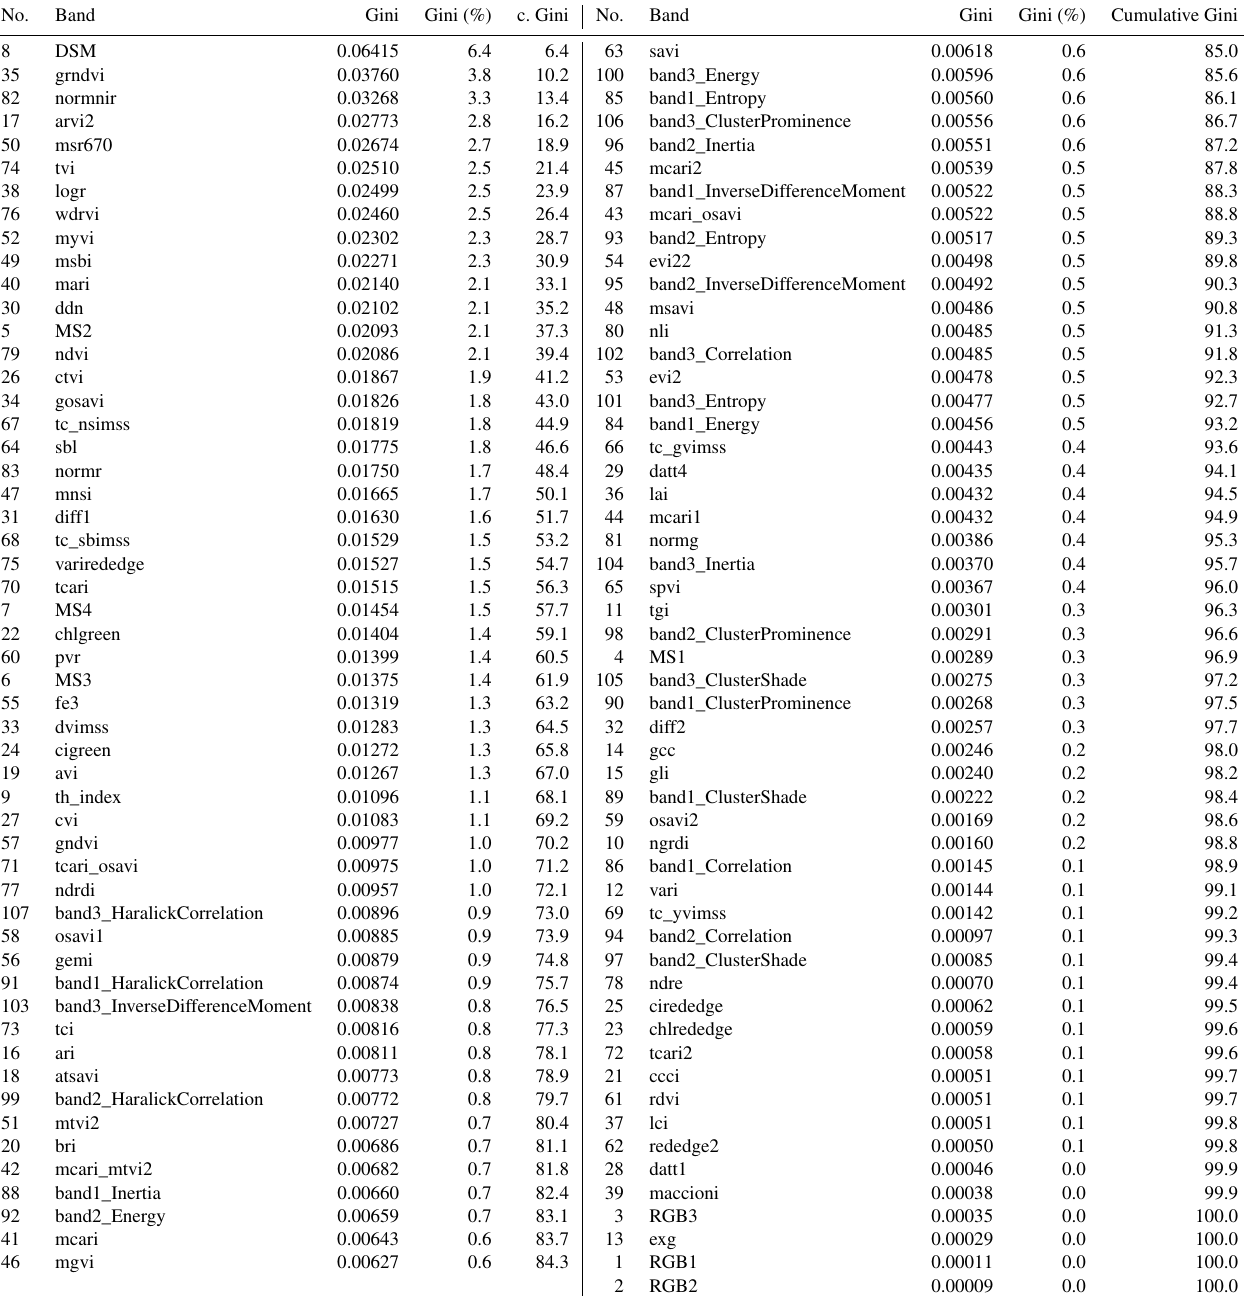
Table C2. All bands of the multisensor data set ordered by the GINI coefficient. The higher the GINI, the more important the band for the random forest